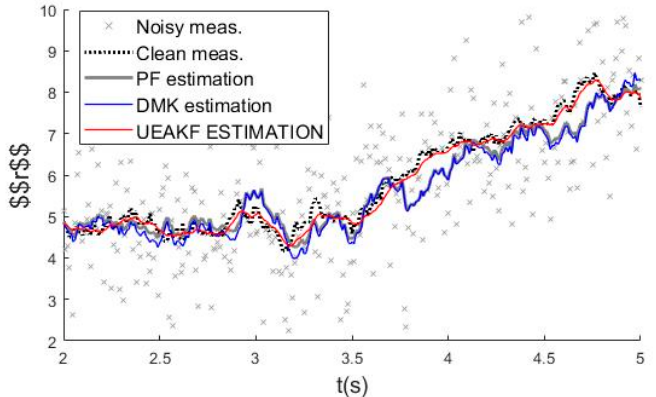
Figure 9. 𝑟 (cid:3041) standard deviation and mean of the 𝑛𝑅𝑀𝑆𝐸 of the clean measurement estimations. Figure 9. r n standard deviation and mean of the n RMSE of the clean measurement estimations. The The 𝑛𝑅𝑀𝑆𝐸 outcomes were averaged over 50 samples of process and noise trajectories. n RMSE outcomes were averaged over 50 samples of process and noise